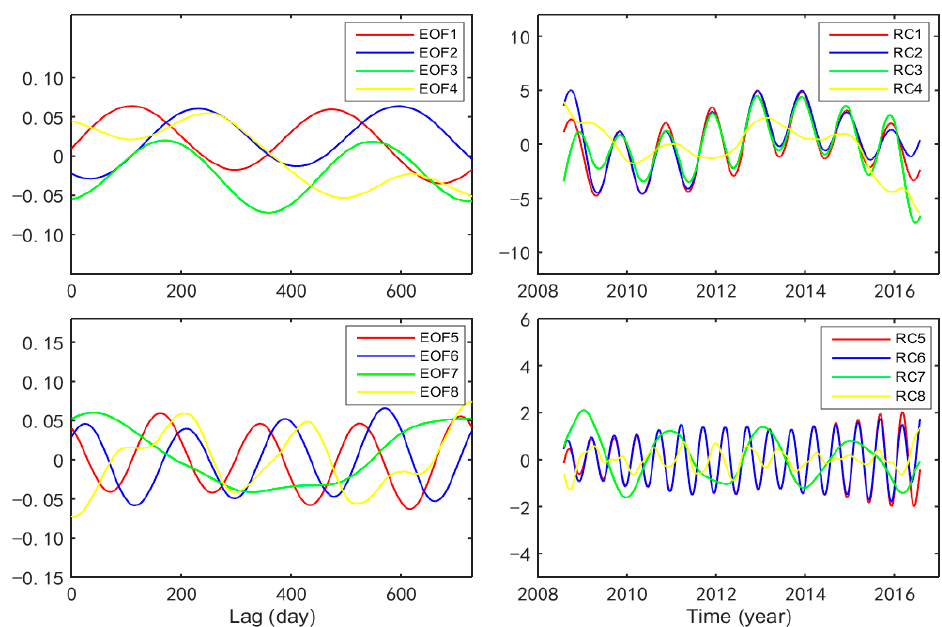
Figure 7. Variations of the first 8 EOFs and RCs in KAGA station vertical coordinates.